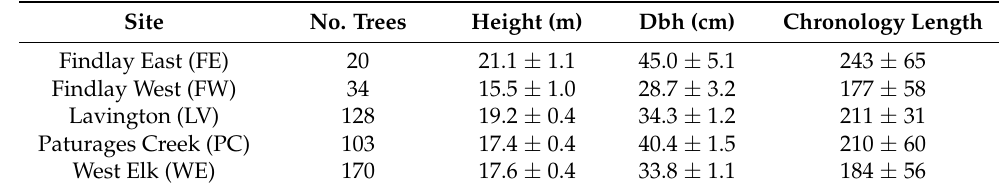
Table 2. Mean metrics of whitebark pine trees retained in harvest units, representing all trees (living and dead)